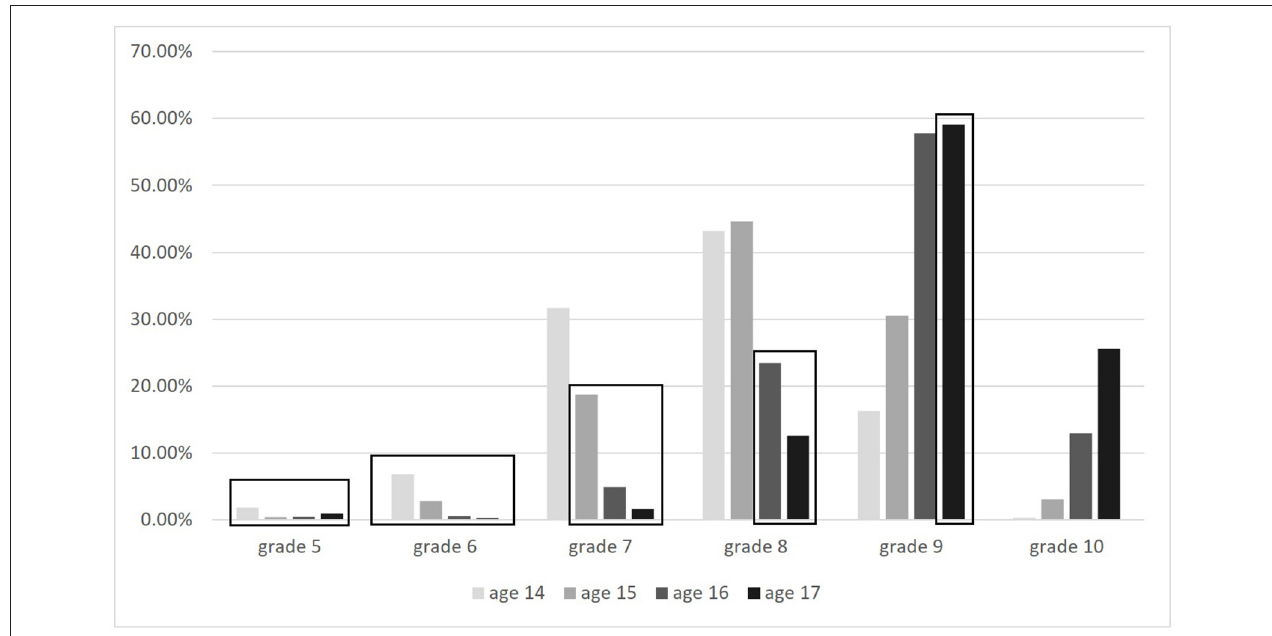
FIGURE 2 | Age and school grade of the refugee adolescents. ReGES data, Refugee Cohort 2–Adolescents, doi: 10.5157/ReGES:RC2:SUF:2.0.0. Highlighted in black boxes are cases which are not age-appropriately enrolled by our definition n =